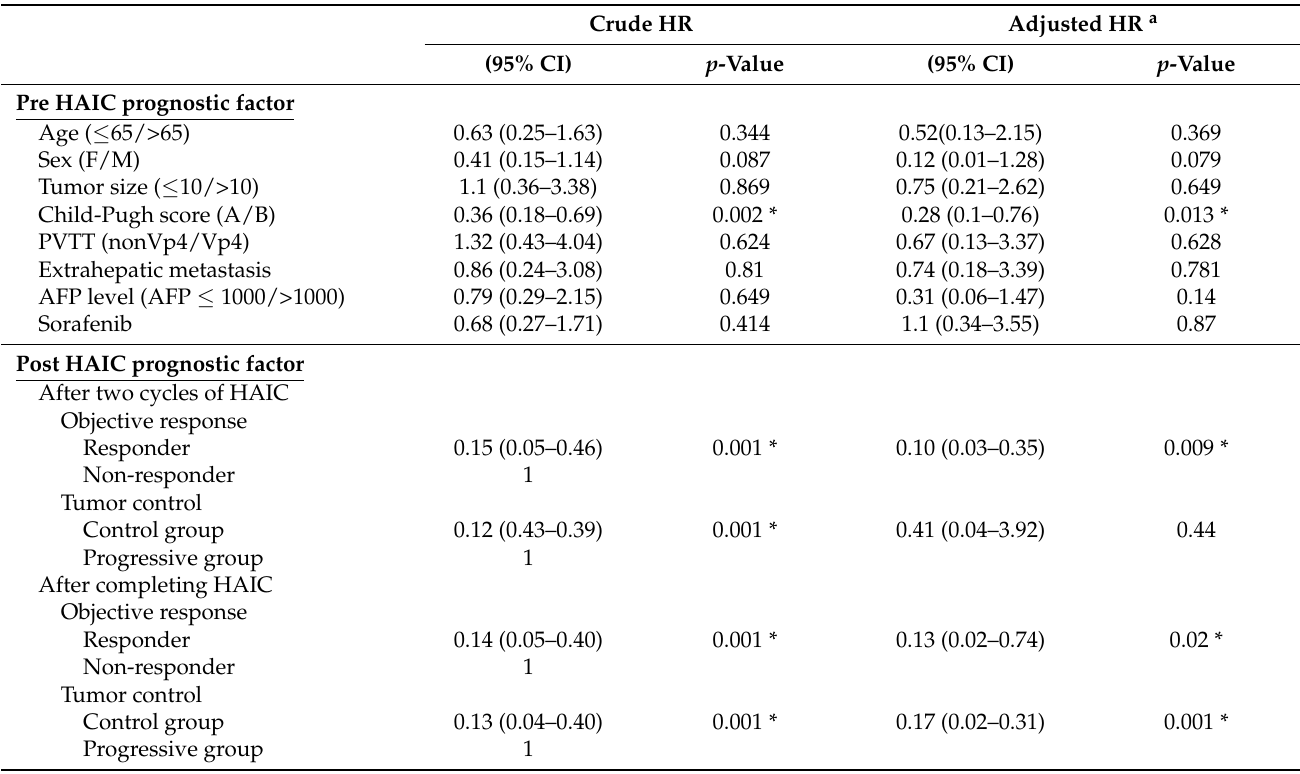
Table 3. Prognostic factors for survival in HAIC followed by lipiodol infusion.